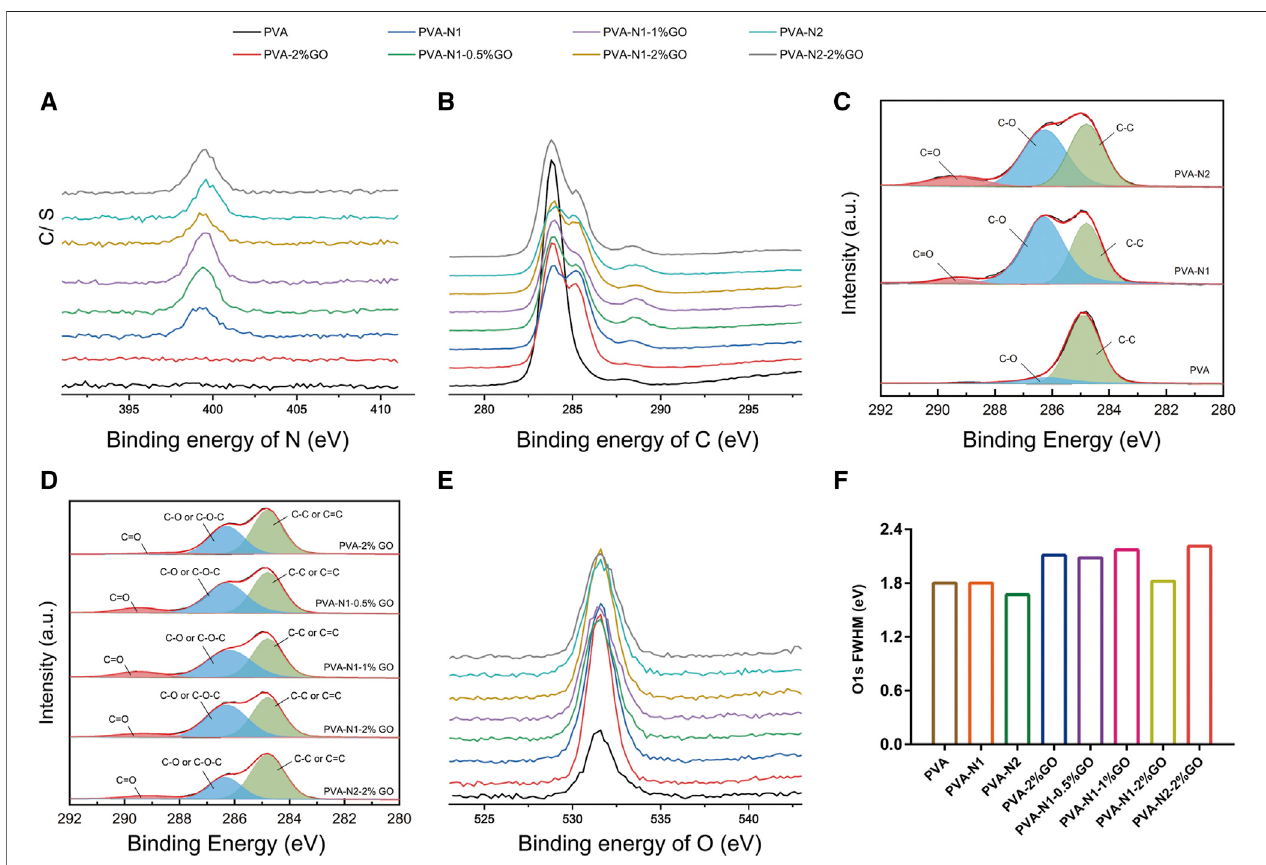
FIGURE 2 | Detailed XPS spectrums of PVA, PVA-N, and their nanocomposites: N1s (A) , C1s (B), and its peak fi tting (C,D) , and O1s (E) and its full width at half maxima (FWHM) (F) .